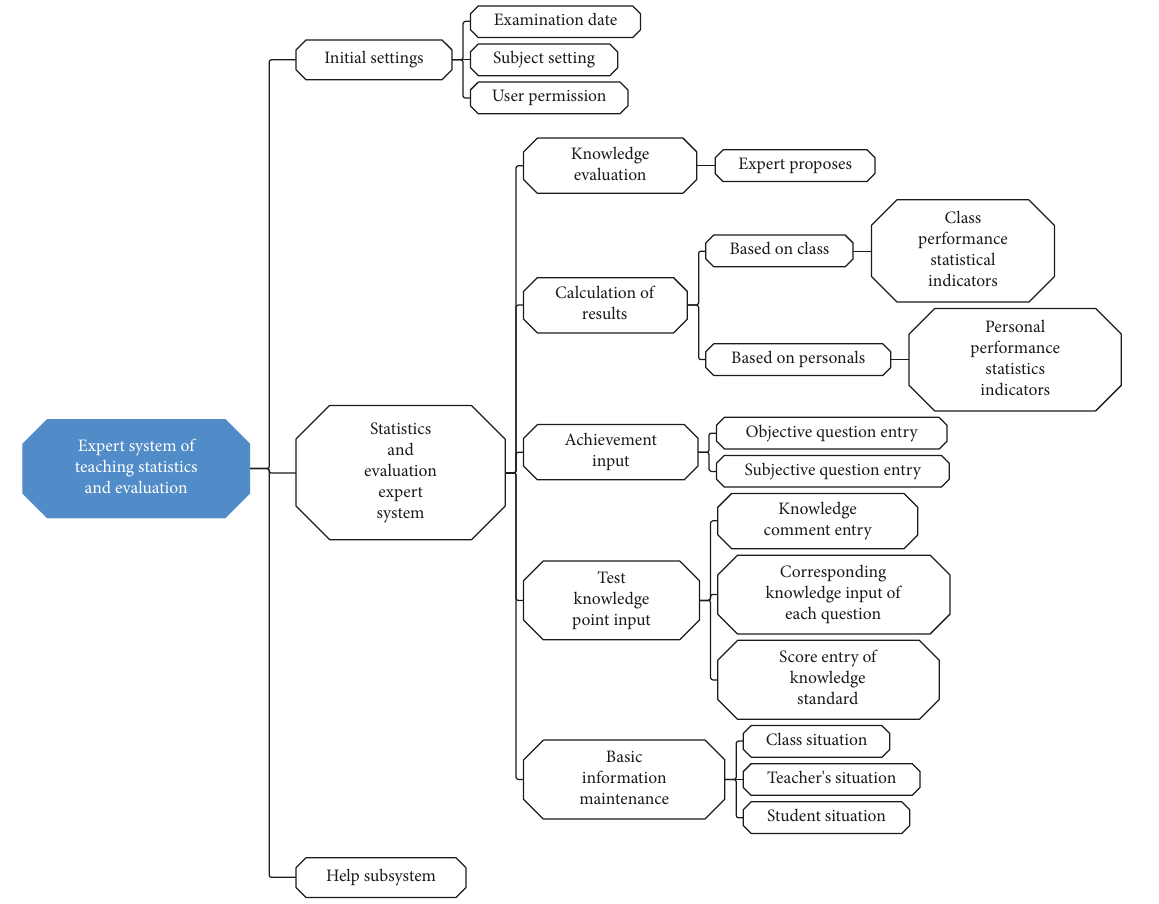
Figure 3: Exploded view of system function